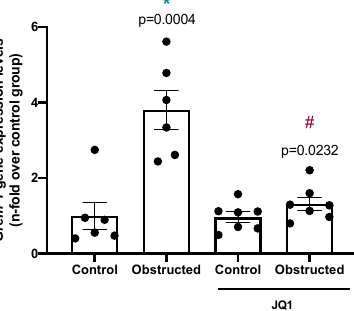
Figure 7. JQ1 diminishes Gremlin-1 in an experimental model of progressive tubulointerstitial fibrosis. Unilateral ureteral obstruction (UUO) was performed in C57Bl/6 mice as described in Methods, and kidneys were studied after 5 days. Some mice were treated with JQ1 (100 mg/kg body weight per day, i.p. starting 24 h before UUO). RNA was obtained from total renal extracts and Grem-1 mRNA levels were determined by real-time qPCR. Data are expressed as the mean ± SEM of 5–7 animals per group. * p < 0.05 vs. control; # p < 0.05 vs. UUO.